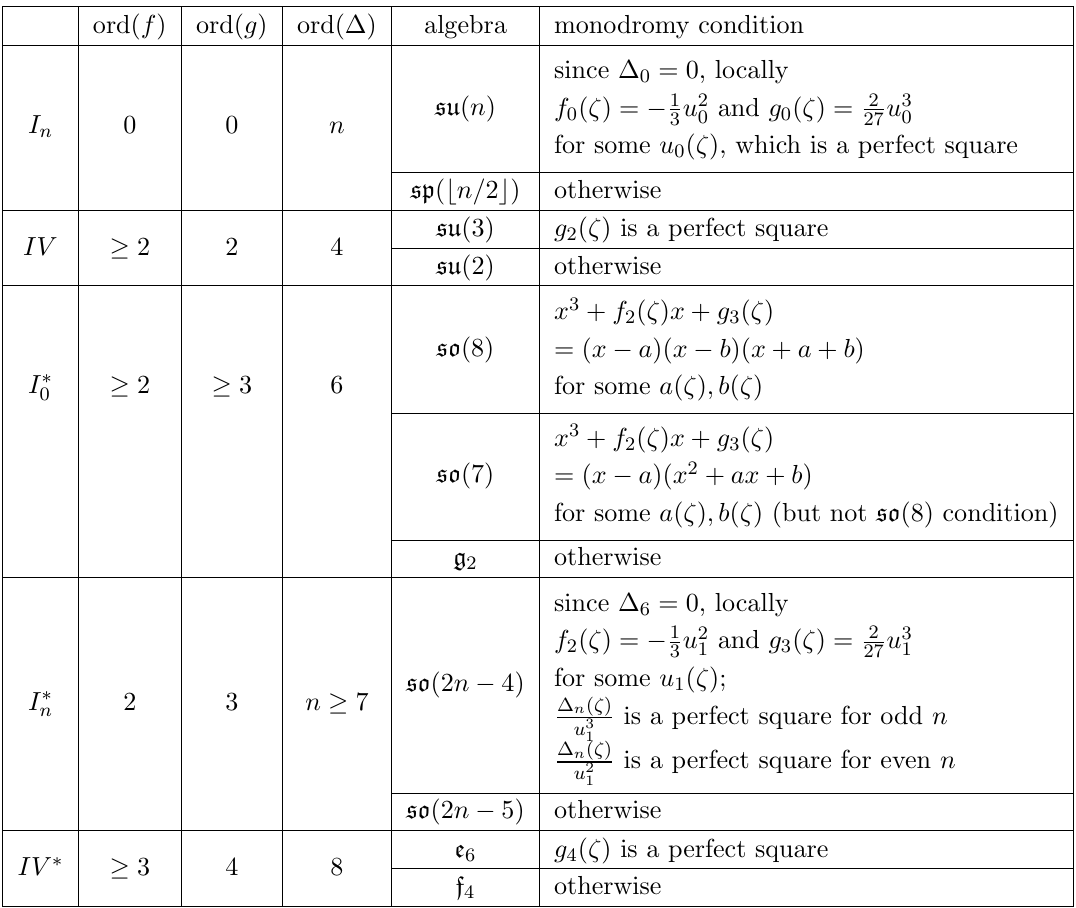
Table 2. Kodaira classi(cid:12)cation of singularities in the elliptic (cid:12)ber along codimension one loci in the base in terms of orders of vanishing of the parameters f; g in the Weierstrass model (2.8) and the discriminant locus (cid:1).